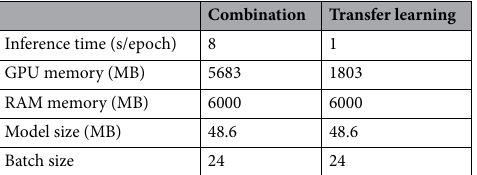
Table 3. Summary of the computational resources needed for the combination ( n = 500 ) and transfer learning approaches ( n = 4000